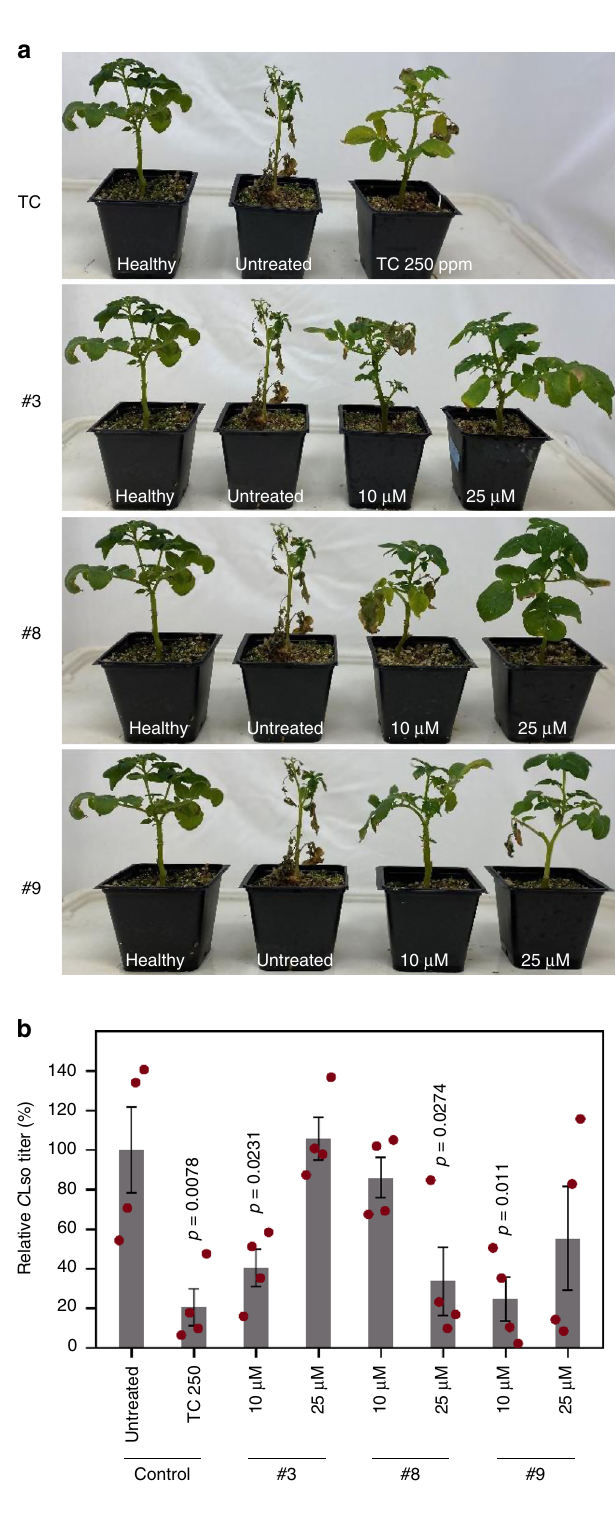
Fig. 5 In planta application of small molecules confer tolerance to Candidatus Liberibacter spp. in potatoes. a Visual symptoms of plants at 28 days post infection (dpi). Tetracycline (TC, 250 ppm) and three selected small molecules (#3, #8, and #9; see Fig. 4) were sprayed on the plants at two concentrations (10 and 25 µ M) as indicated. Disease symptoms of chlorosis, necrosis, leaf curling, and wilting were monitored. b C Lso titers were determined by qPCR at 28 dpi. All titers are plotted relative to those of untreated samples, which were set to 100%. Error bars represent ± standard error of mean ( n = 4). p Values were calculated by two-sample t test (one-tailed) relative to untreated samples. Source data underlying Fig. 5b are provided as a Source Data